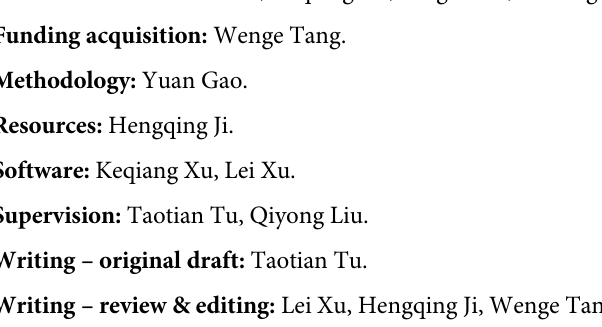
S1 Table. Descriptive analysis of variables from 2007 to 2019 in Chongqing. S2 Table. Correlation analysis using Pearson’s correlation test. S3 Table. Comparison of model performance using the Root Mean Square Error